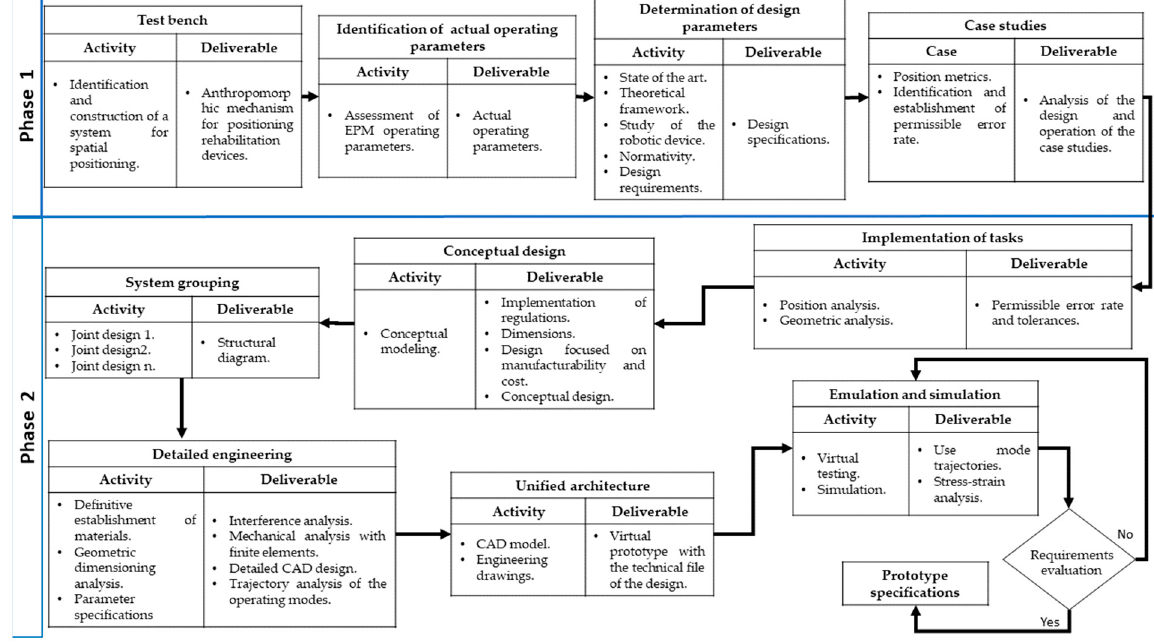
Figure 2. Methodology for increasing the TRL of the ERMIS exoskeleton design.